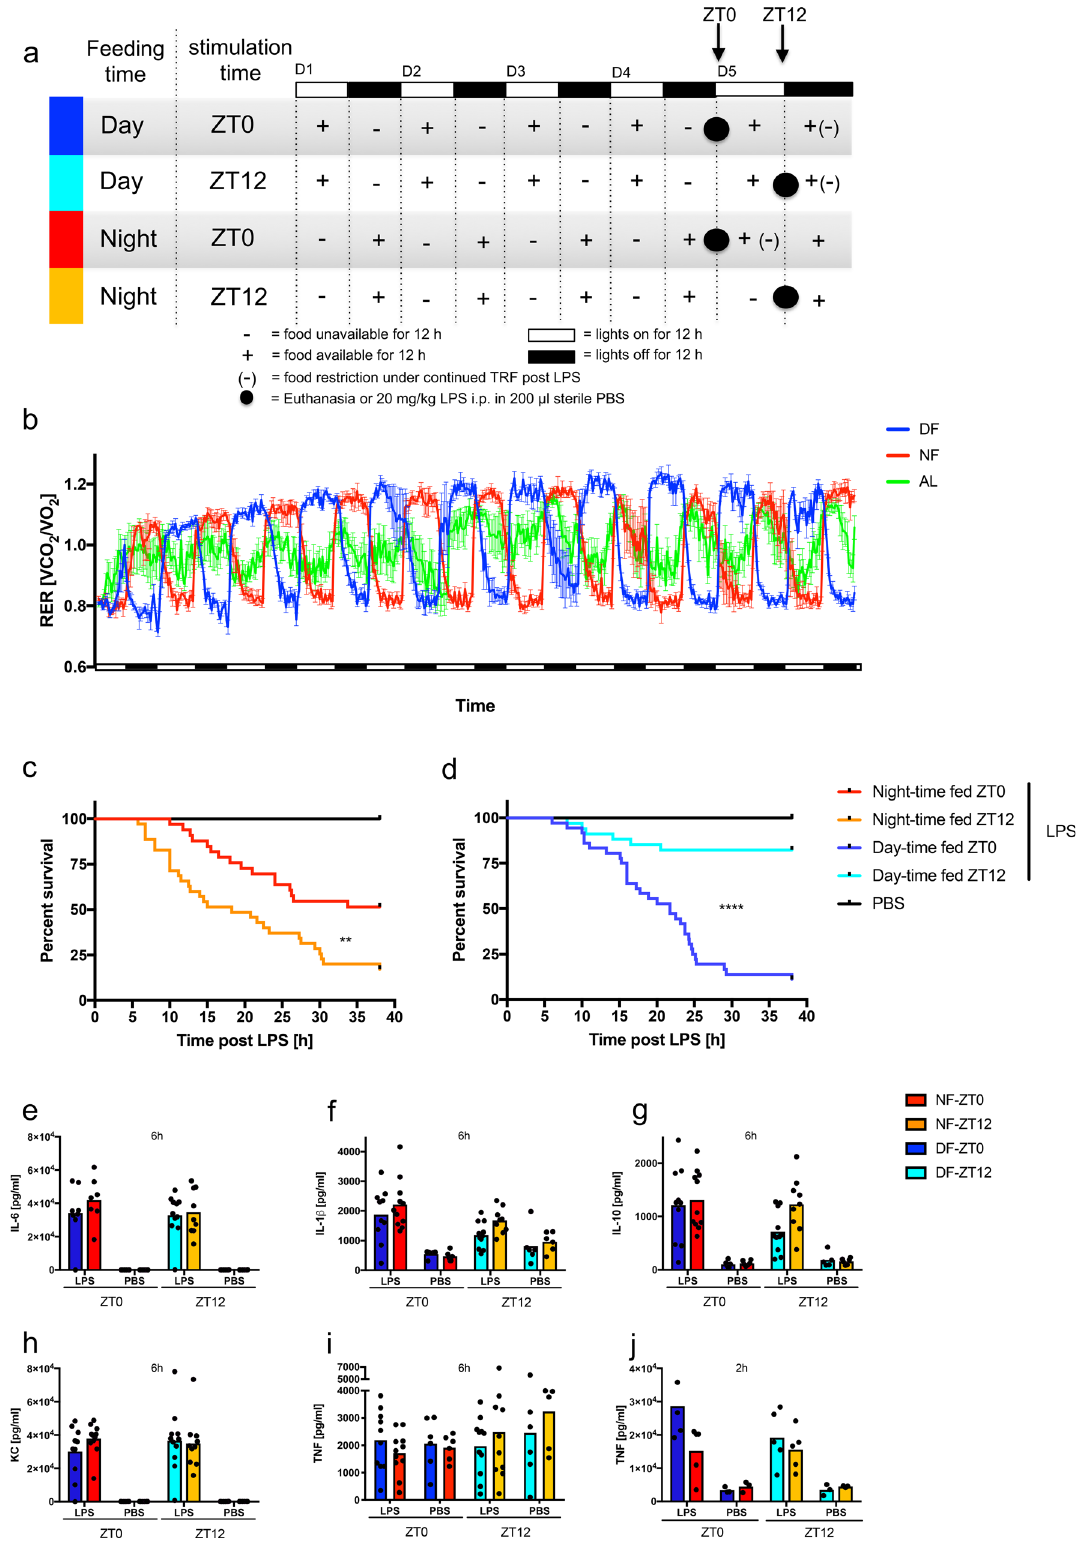
The liver-intrinsic circadian clock rapidly adapts to changes in greatest (Fig. 2e). As expected, glucocorticoids rose after the LPS the feeding cycle . To better understand the in fl uence of food and challenge but were not different between feeding groups and time of stimulation nor the post-stimulation feeding regimen (Fig. 2f), light cycle on the circadian clock and downstream metabolic and showing that endogenous corticosteroids are not likely a key in fl ammatory outputs, we measured expression of key circadian protective factor in food-cycle controlled LPS-induced mortality. clock components in the liver and spleen in NF or DF mice NATURE COMMUNICATIONS| (2021) 12:2745